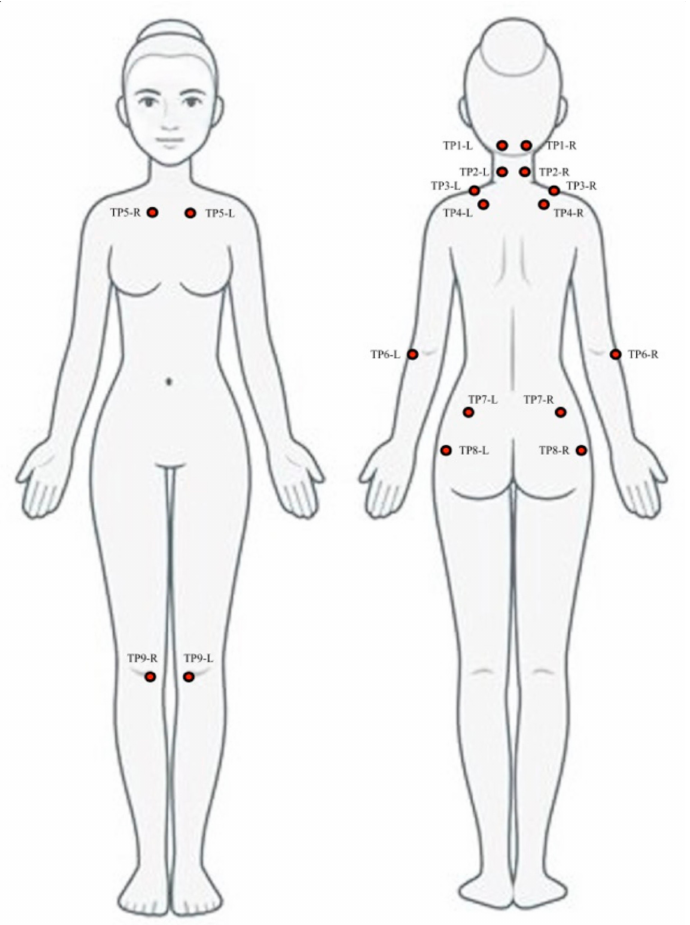
Figure 1. Examined locations of Tender Points assessed in this study. L: Left; R: